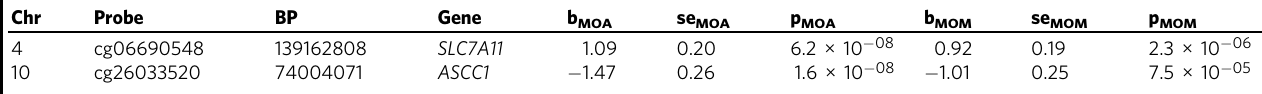
Table 2 Epigenome-wide signi fi cant probes identi fi ed in the meta-analysis of SGPD and PEG.